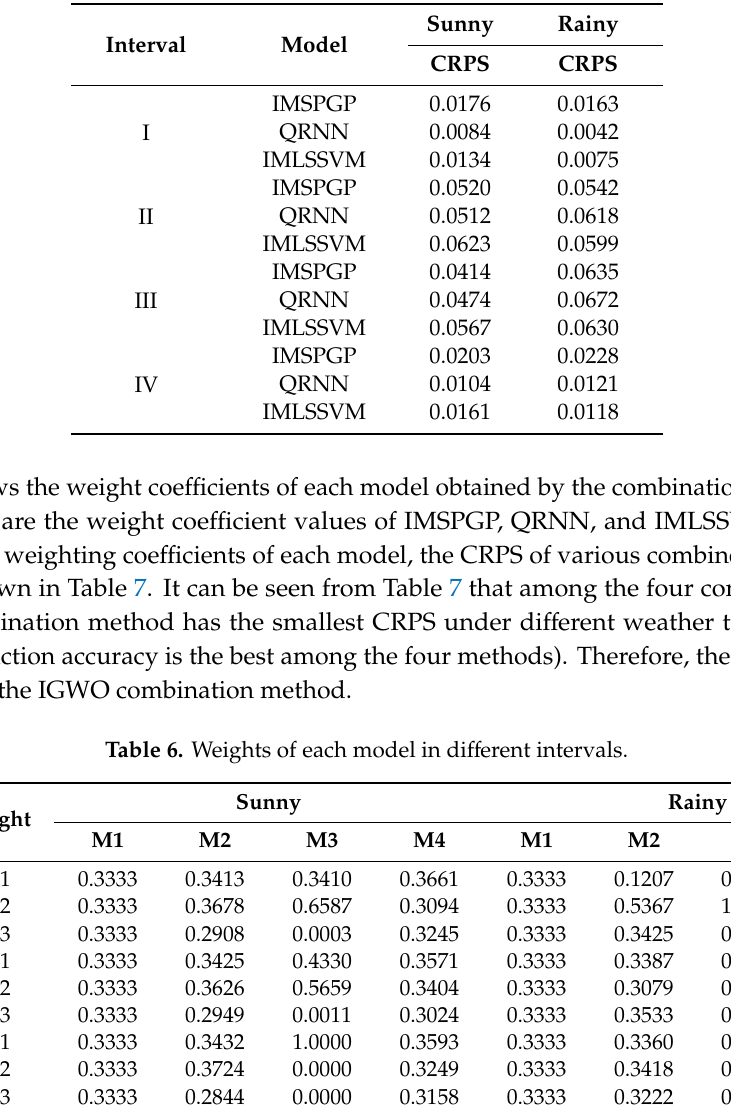
Table 5. CRPS of each model in di ff erent intervals.